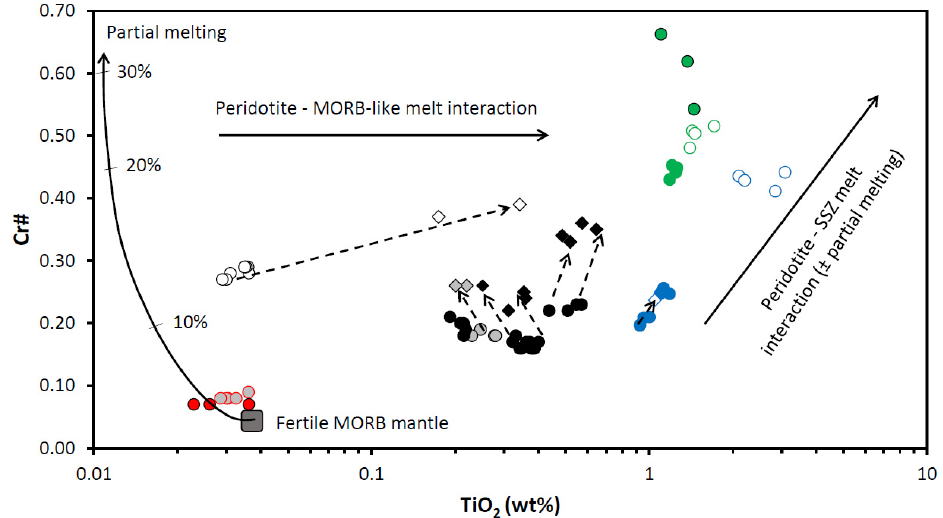
Figure 13. Diagram TiO 2 (wt%) vs. Cr# for spinels from the East Antarctic peridotite xenoliths. “Fertile MORB mantle partial melting“ trend, “Peridotite–MORB-like melt interaction“ trend and “Peridotite–SSZ melt interaction“ trend are after [28]. Ticks on the “Fertile MORB mantle partial melting“ trend are degrees of the partial melting and melt extraction (after [28,39]). Symbols are as in Figure 9.